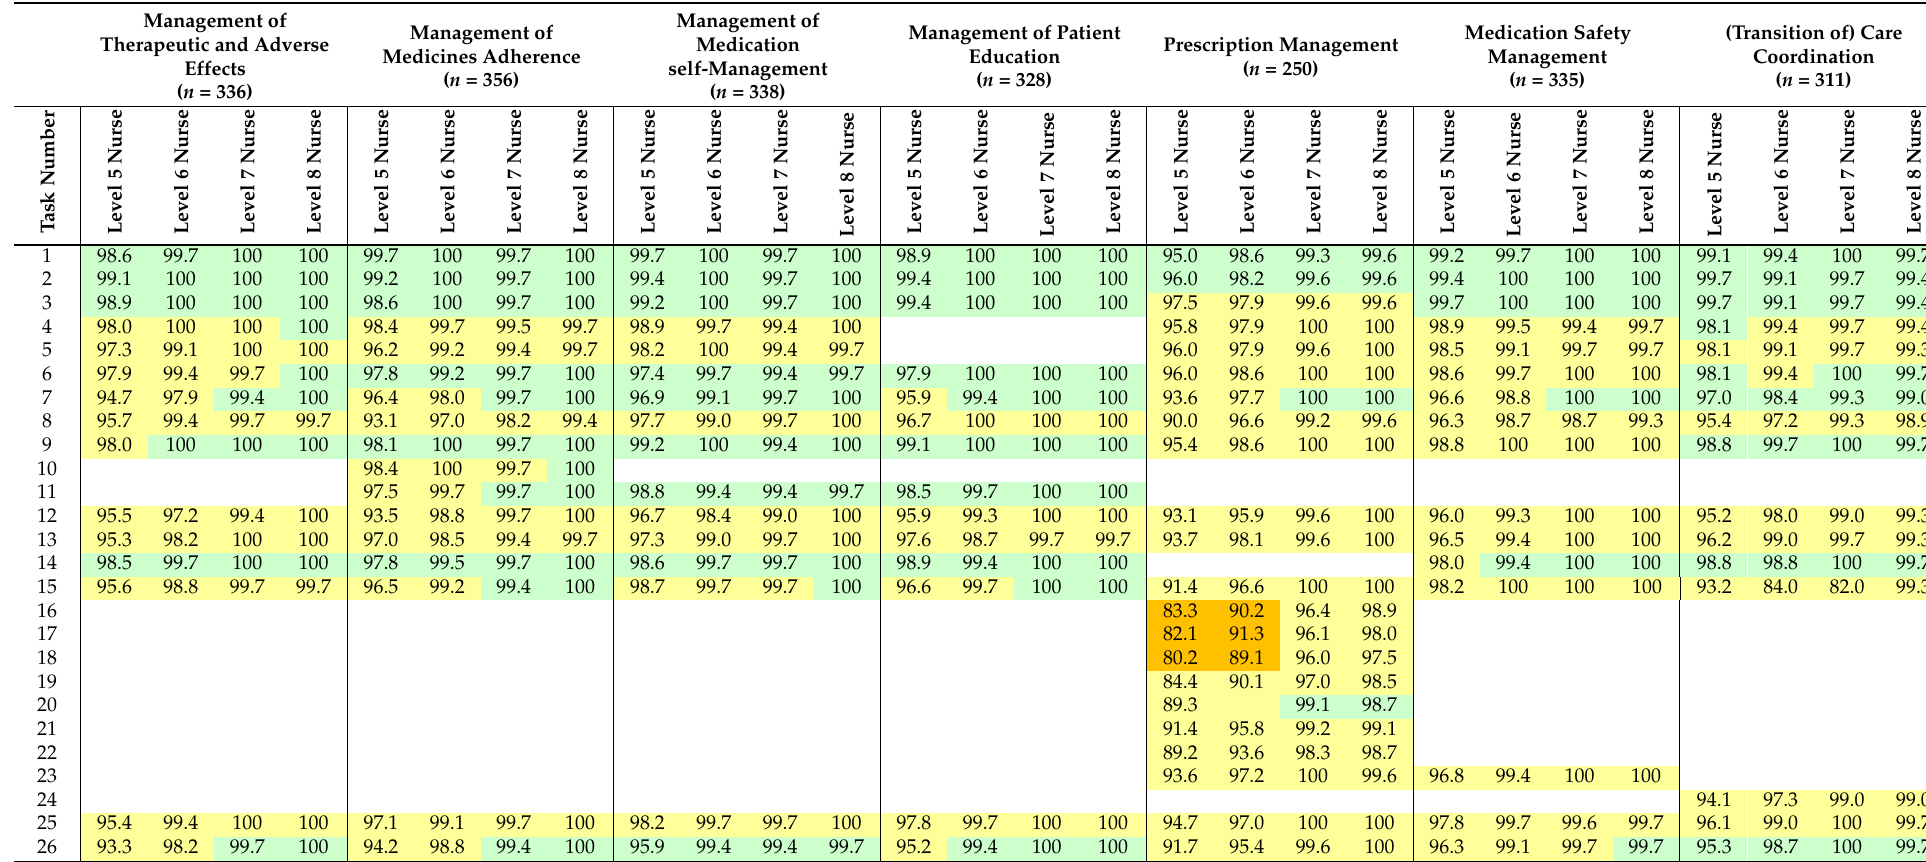
Table A5. Percentages of healthcare professionals considering 26 tasks in seven pharmaceutical care domains as nursing tasks in order to perform best quality of care and patient outcomes, distinguished between level 5-6-7-8 *